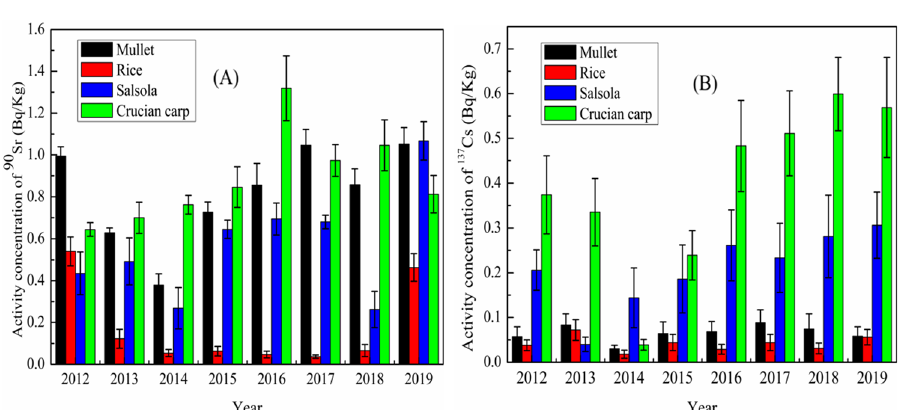
Figure 4. Activity concentrations of 90 Sr ( A ) and 137 Cs ( B ) in different food samples (mullet, rice, salsola, and crucian carp) collected around QNPP during